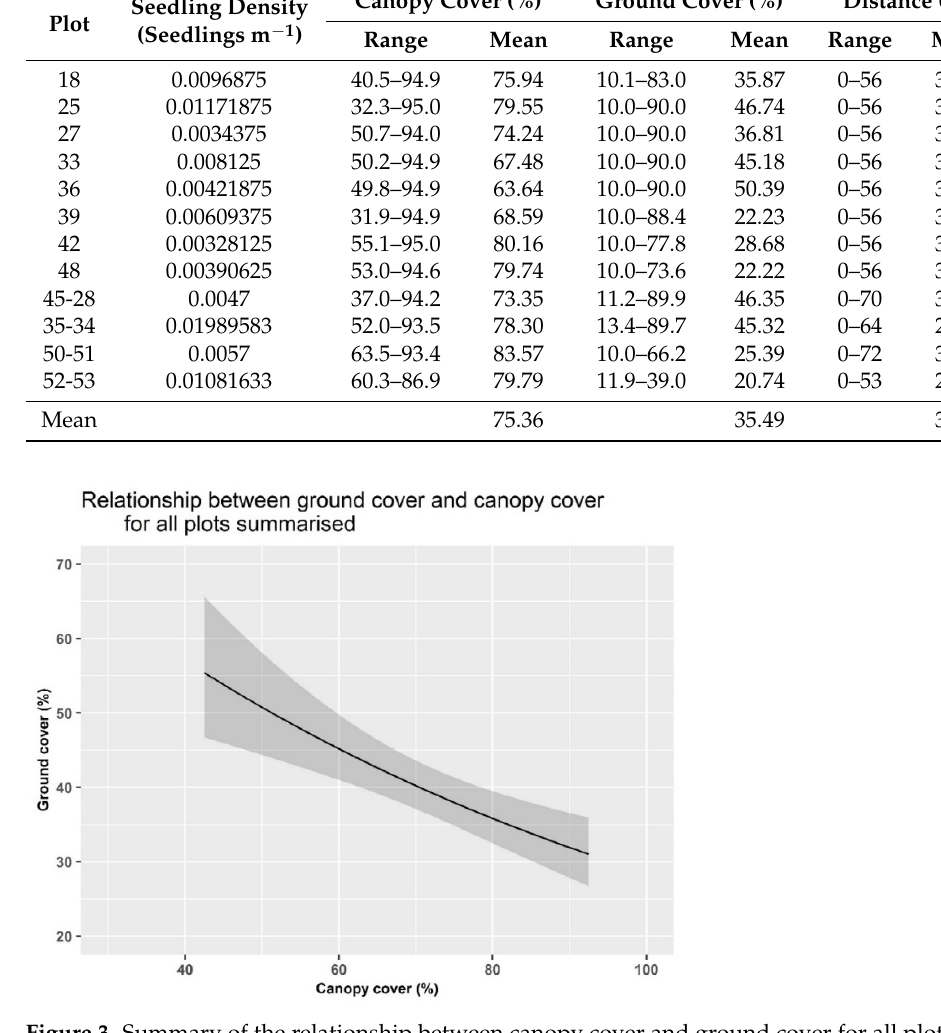
Figure 3. Summary of the relationship between canopy cover and ground cover for all plots; non- parametric smoother and 95% confidence